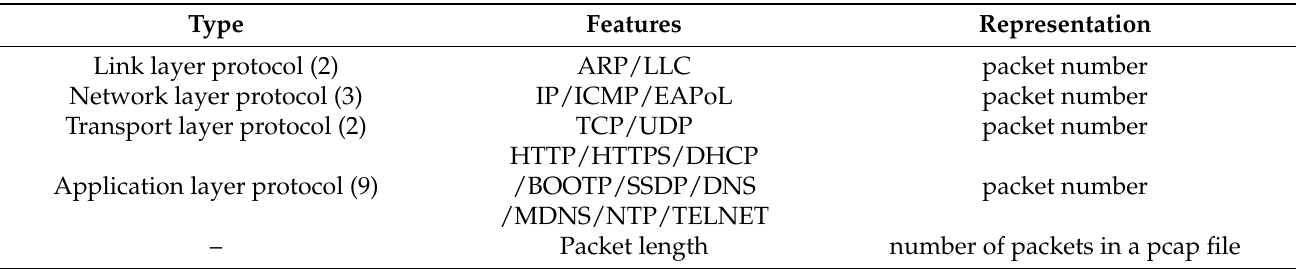
Table 2. Description of the packet features.